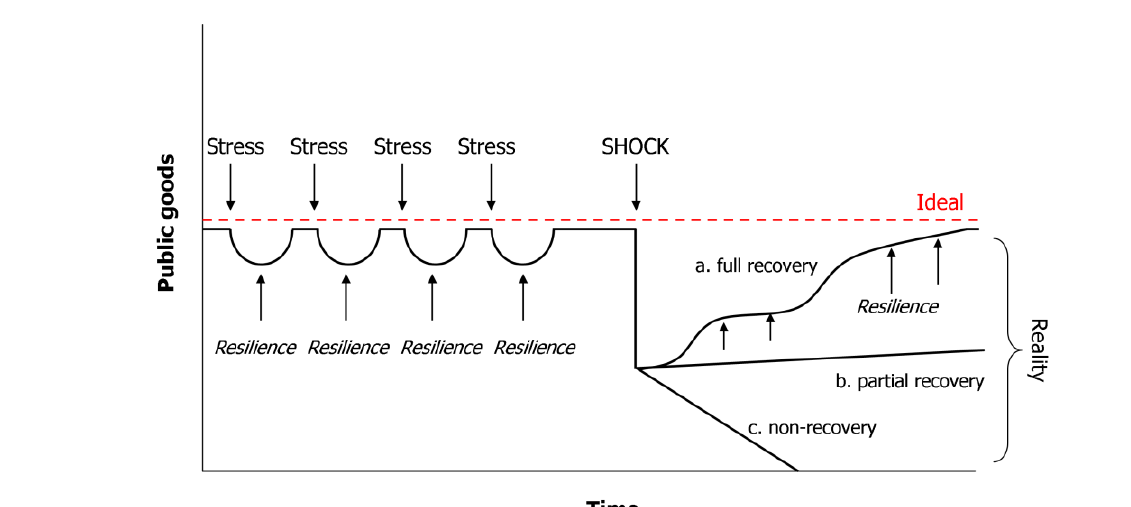
Figure 4. Resistance towards stresses and shocks.